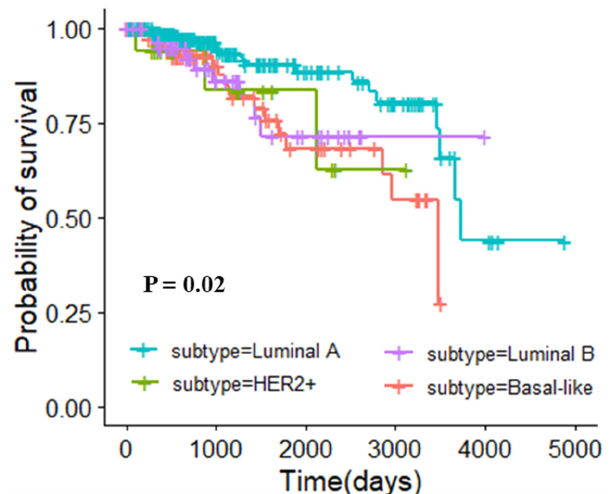
Figure 3. Survival analysis of primitive typing in breast invasive carcinoma dataset.